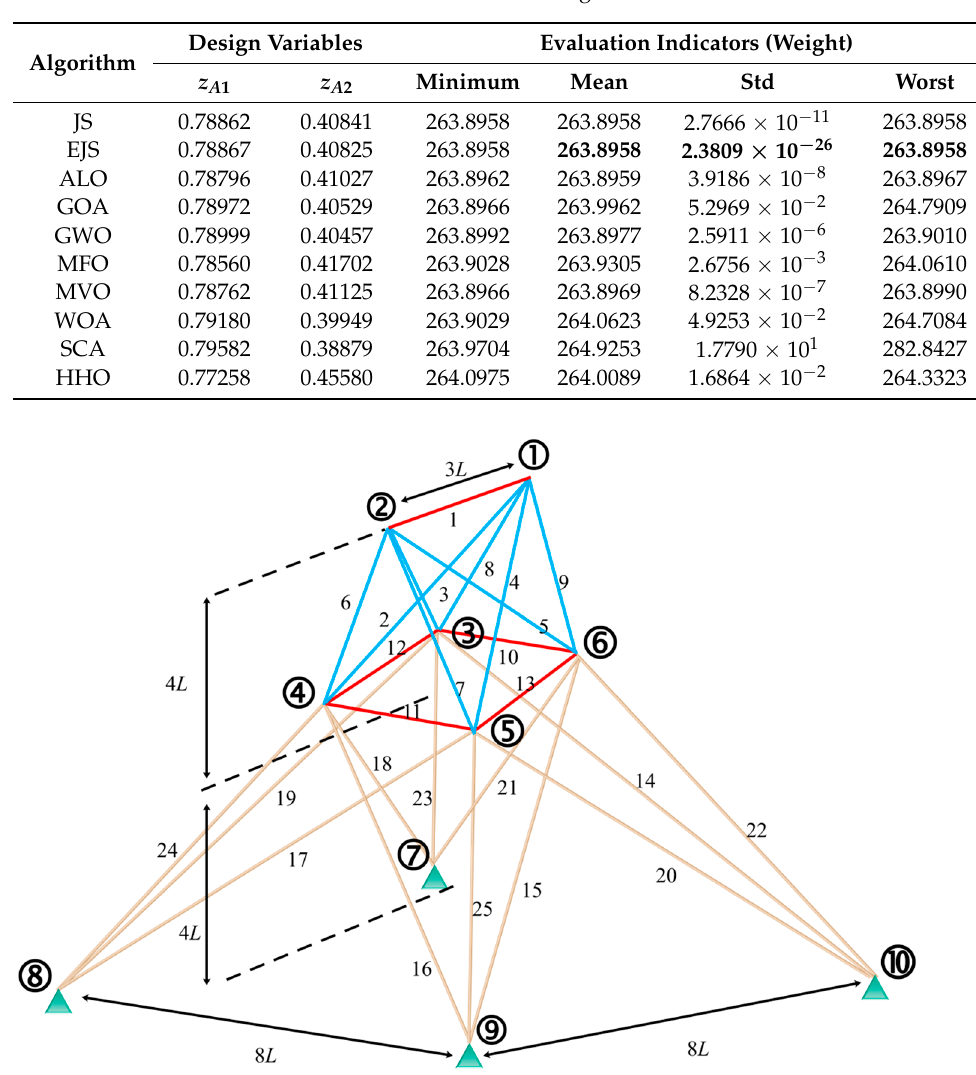
Table 12. Evaluation indicators of all the algorithms for Figure 13.